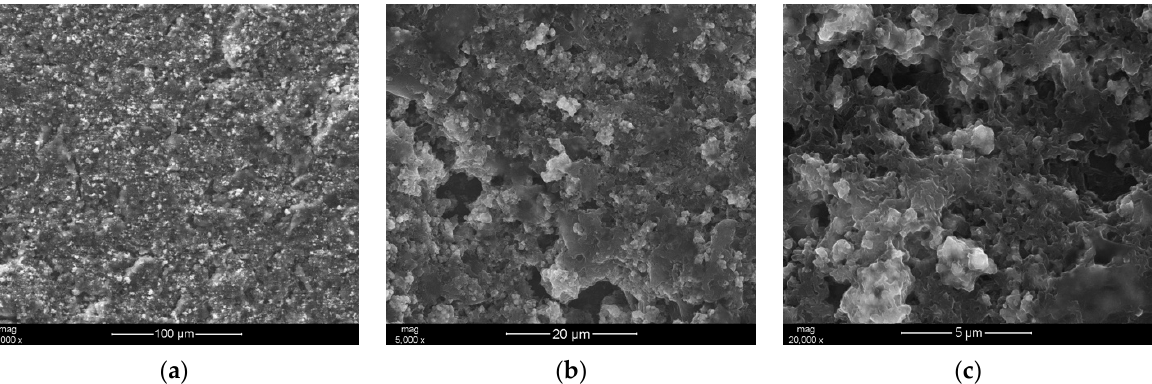
Figure 2. SEM images showing the morphology of the RuO 2 —PEDOT:PSS composite. ( a − c ) Magnification series from the lowest to the highest magnification.